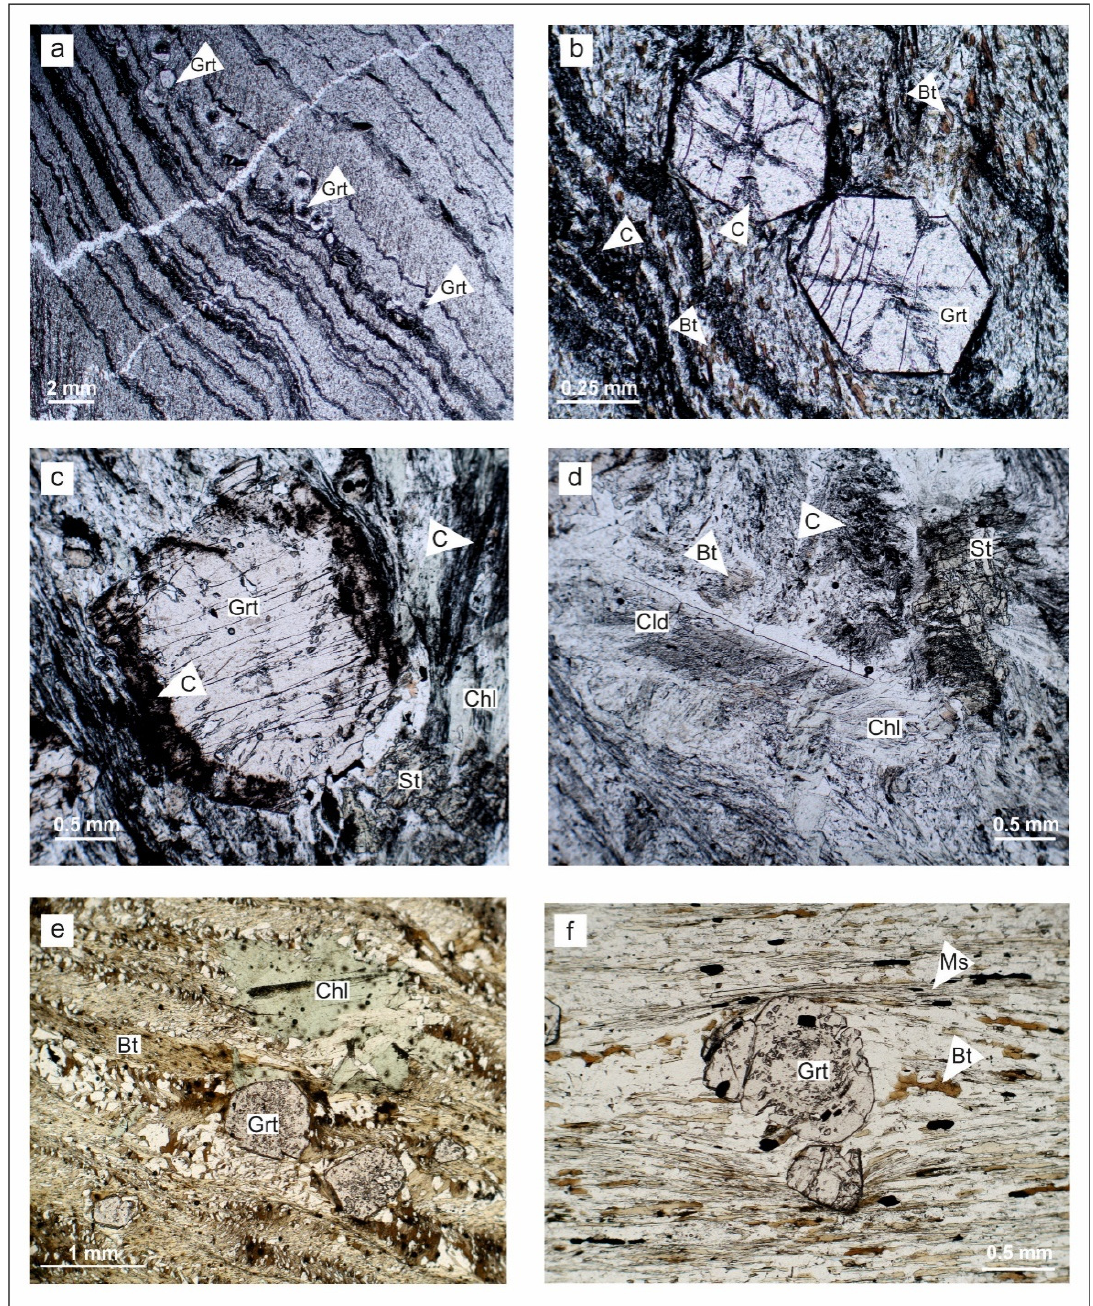
Figure 3. Photomicrograph of thin sections from the host schists of the gold deposits: ( a – e )–Olympiada: ( a , b )—oc-40; ( c , d )—oc-24; ( e )—oc-99; ( f )—Eldorado, 19-el-2.